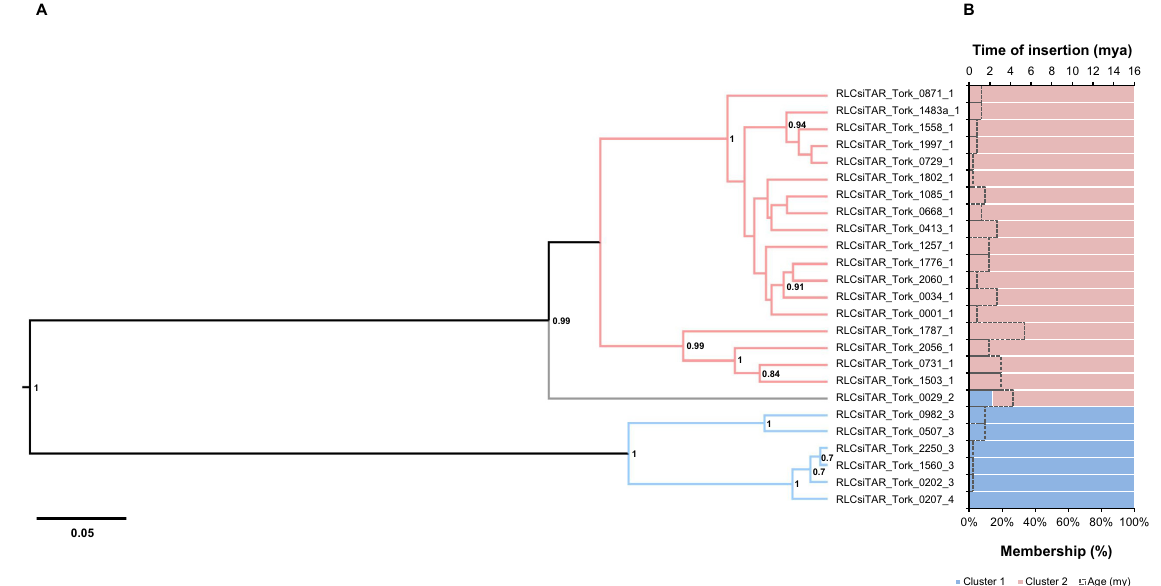
Fig 3. Evolutionary relationships of the TAR/Tork lineage elements. (A) Bayesian phylogenetic tree based on RT amino acid sequences. Posterior probability values below 0.7 are not shown. (B) STRUCTURE plot (colored bars, bottom axis) based on RT sequences, showing the percentage of membership of the elements in the clusters and time of insertion (dotted bars, upper axis) based on the LTR sequences. In both the tree branches and plots, each color represents a cluster. The numbers at the end of the name of the elements indicate the family. The tree and STRUCTURE plot were based on an amino acid alignment with 251 positions. mya: millions of years ago; my: millions of years.